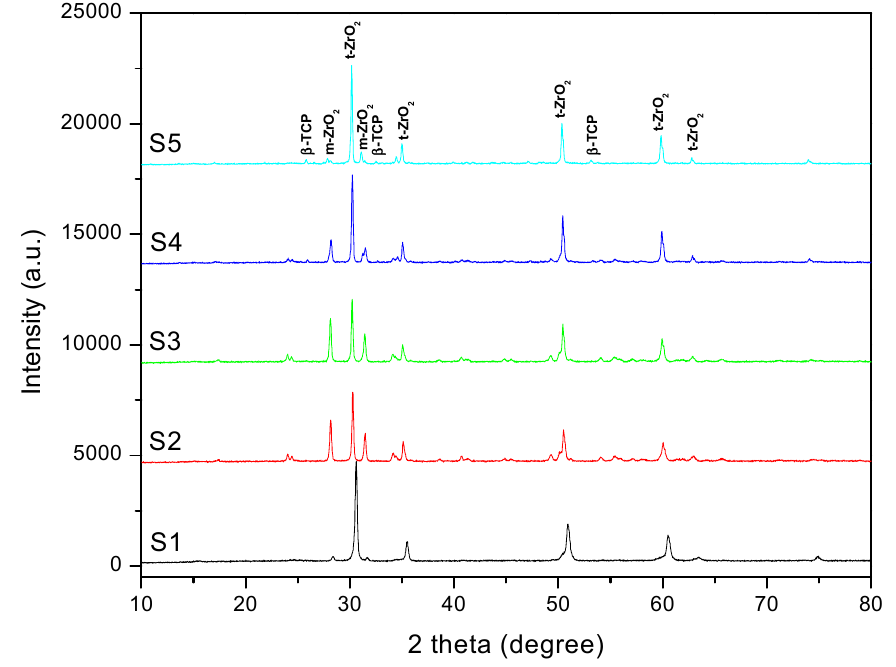
Figure 1. XRPD patterns of the prepared composites.